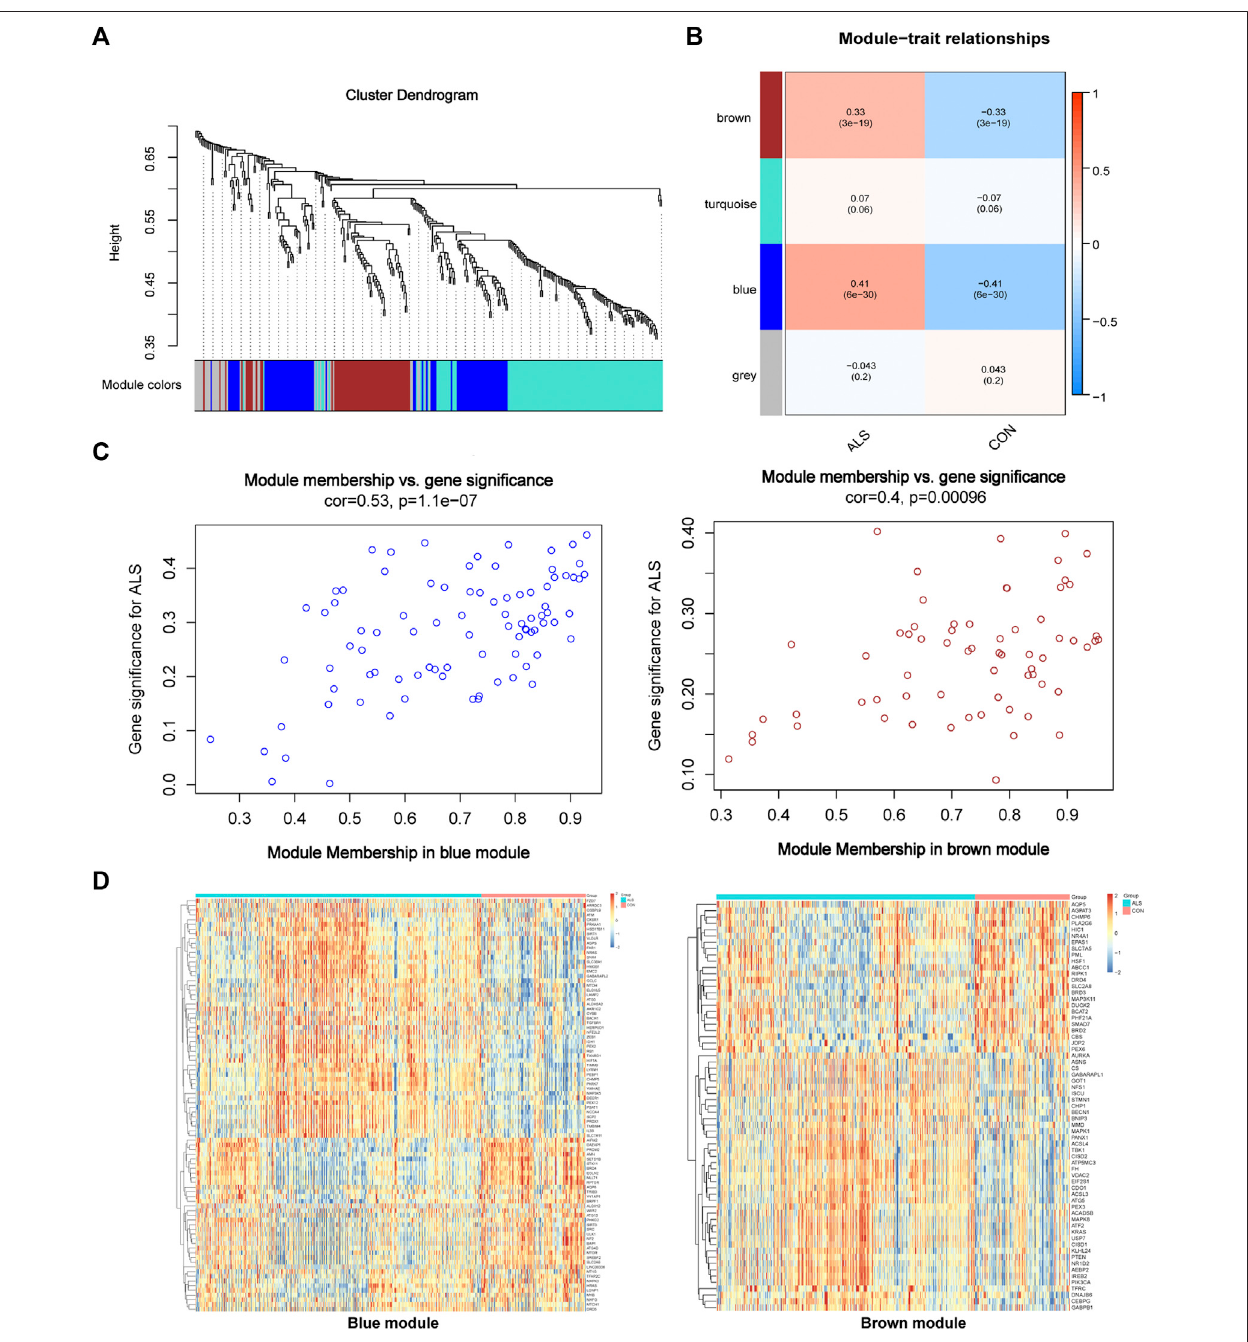
FIGURE 3 | Visualization of WGCNA results. (A) WGCNA cluster dendrogram groups genes into distinct four modules. (B) Correlation between each module ’ s eigengene and phenotype. Two modules were positively correlated with ALS, namely, the brown and blue modules. All modules are marked with different colors. (C) Scatter plot of module eigengenes in the brown and blue modules that signi fi cantly correlated with ALS ( p < 0.05). (D) Heatmap pro fi ling of the genes of brown and blue modules derived from WGCNA. Abbreviations: WGCNA, weighted gene correlation network analysis; ALS, amyotrophic lateral sclerosis.